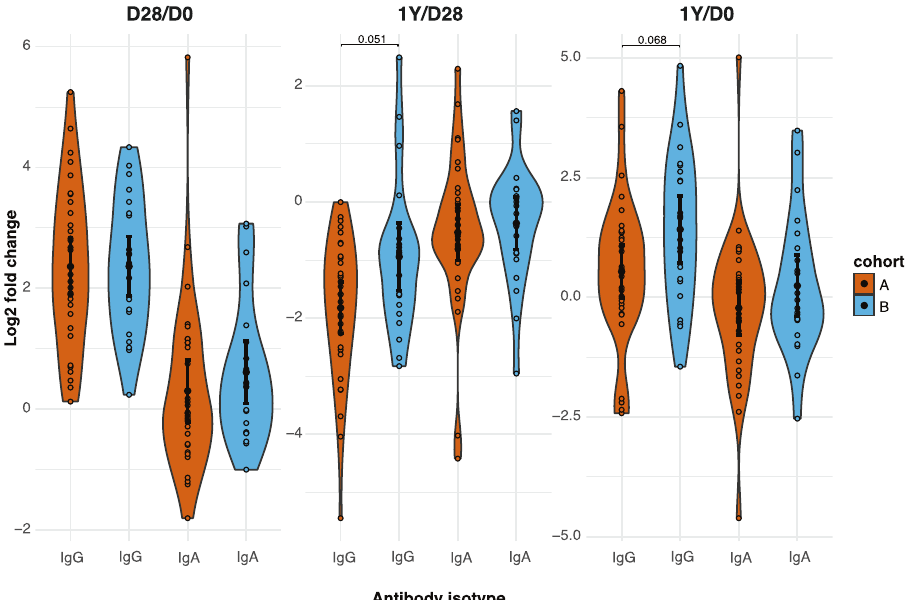
Fig. 6 | Effect of vaccination on mucosal antibody response to B. pertussis . Longitudinal changes in IgG and IgA Bp_wt mucosal deposition levels (log2-trans- formed mean fl uorescenceintensity)atD28overbaseline,Y1overD28andY1over baseline were calculated as log2 fold changes for each cohort. Sample means with